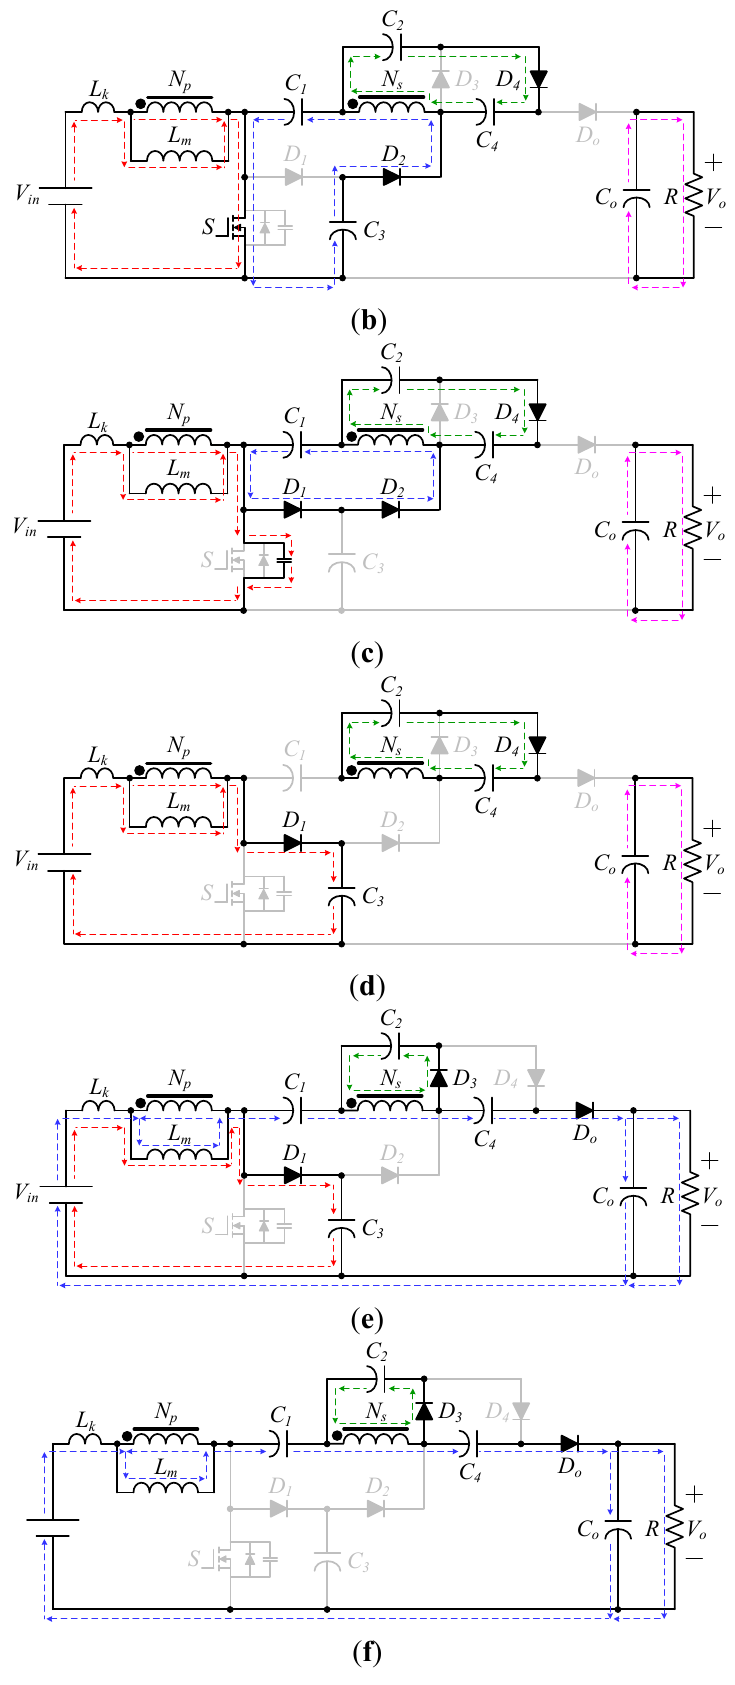
Figure 4. Equivalent circuits of the proposed converter. ( a ) Stage 1; ( b ) Stage 2; ( c ) Stage 3; ( d ) Stage 4; ( e ) Stage 5; and ( f ) Stage